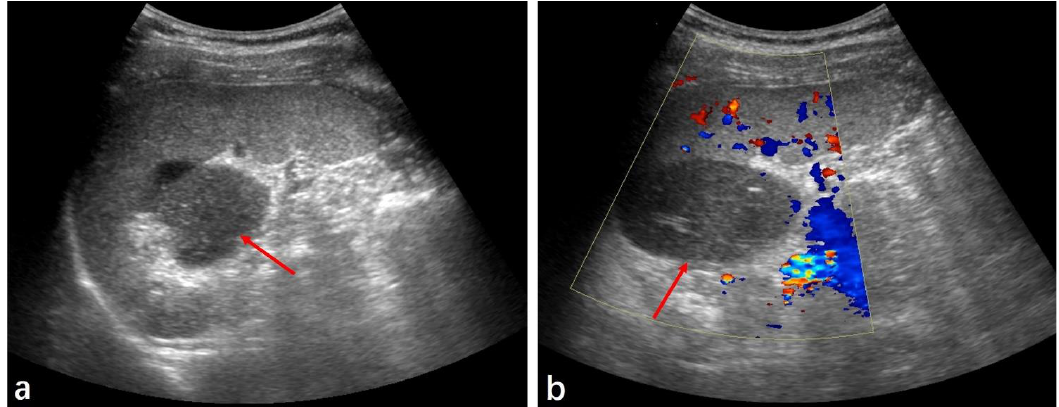
Figure 2. Ultrasonography of the patient’s abdomen. ( a ) Ultrasound showed a solid mass at the splenic hilum (red arrow). ( b ) Color Doppler showed no significant blood flow (red arrow).